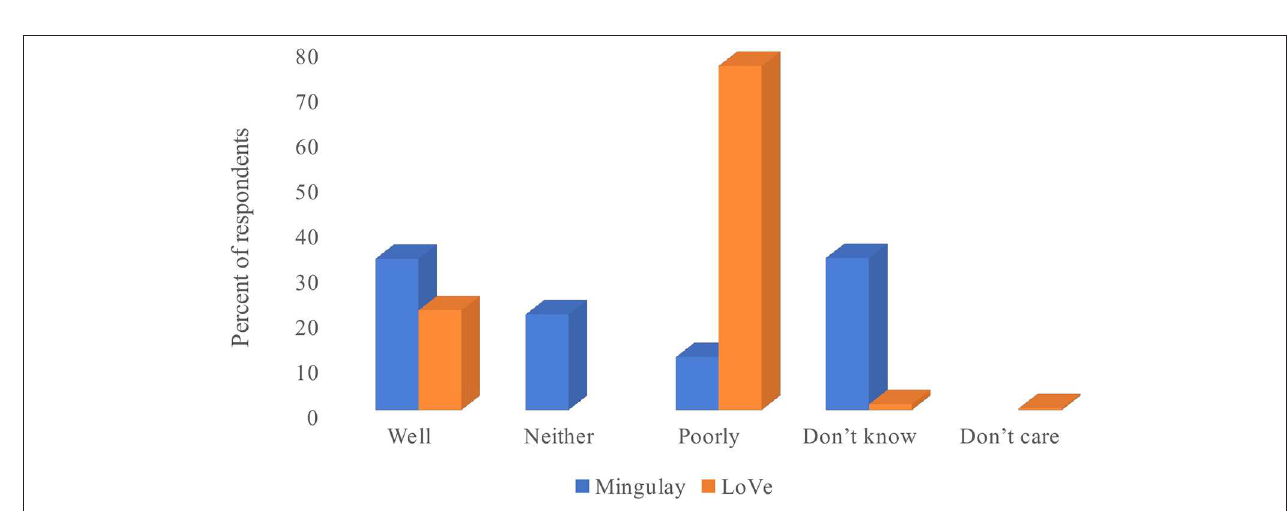
FIGURE 5 | Rating of deep-sea